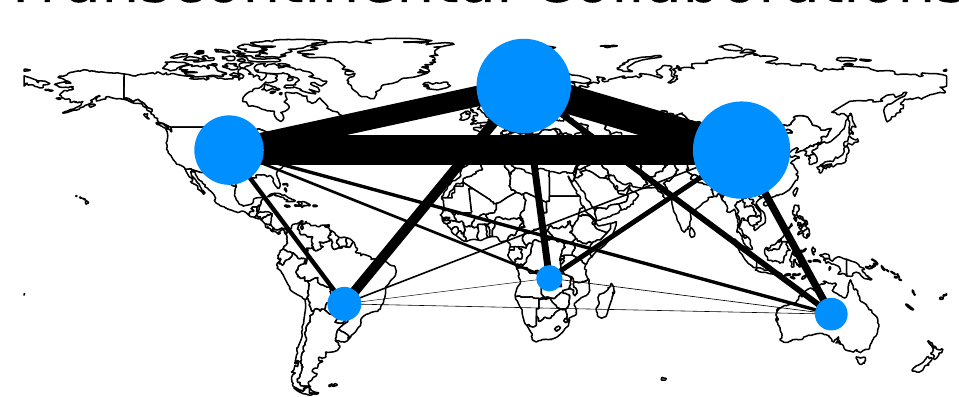
Figure 17. This is the vertex- and edge-weighted graph of trans-regional collaborations superimposed on a map of the world.